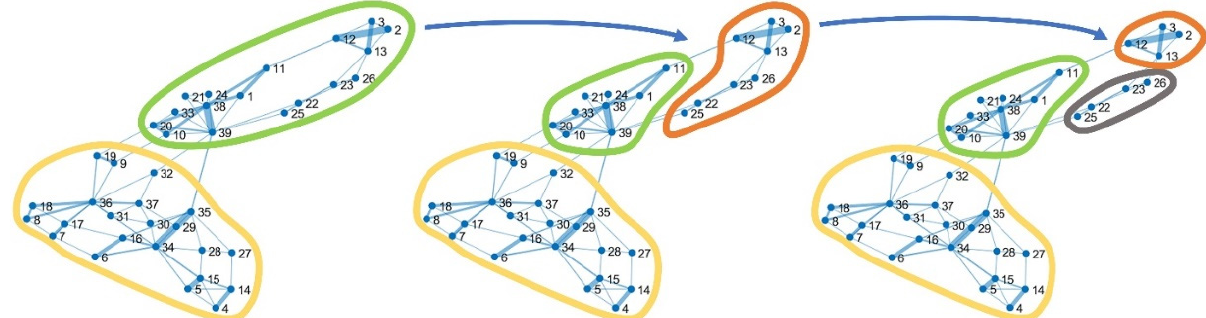
Figure 4. Iteratively cutting a point cloud graph into meaningful clusters using the ℓ (cid:2868) cut pursuit algorithm. The point cloud graph is composed of nodes (numbered) and edges (lines between nodes).